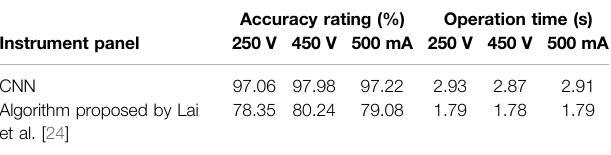
TABLE 4 | | Comparison of veri fi cation results of the data set between the algorithm used in this system and a traditional algorithm [24]. Accuracy rating